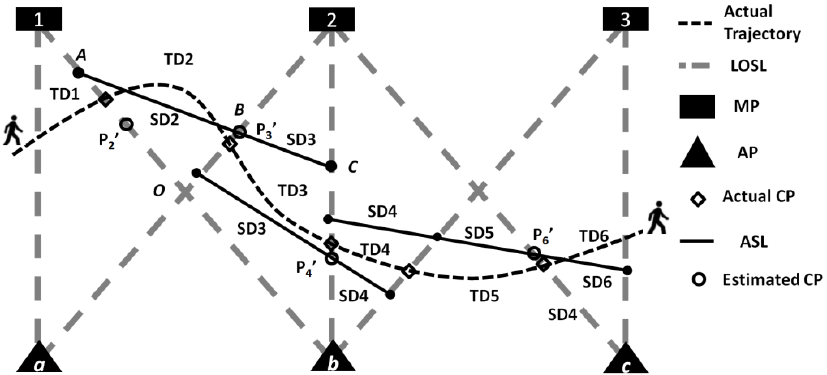
Figure 6. A common abstracted two-dimensional (2-D) passive tracking scenario under low density wireless nodes.